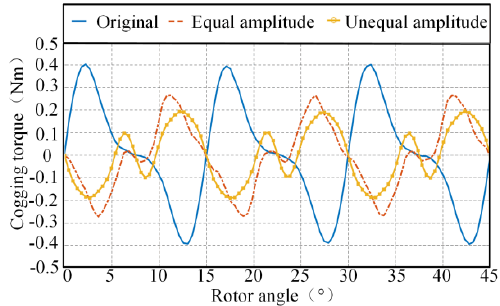
Figure 7. Comparison Results of Cogging Torque.